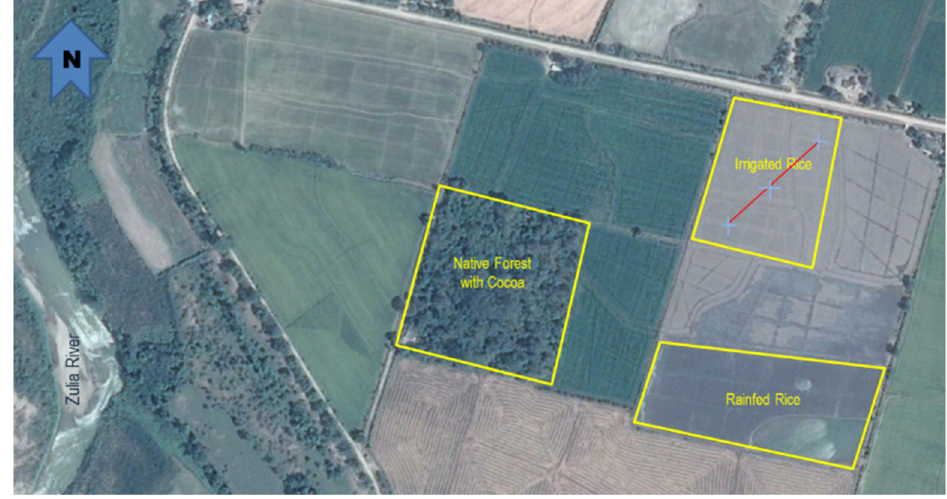
Figure 1. Satellite image of the study site taken on January 2016 from Sentinel.